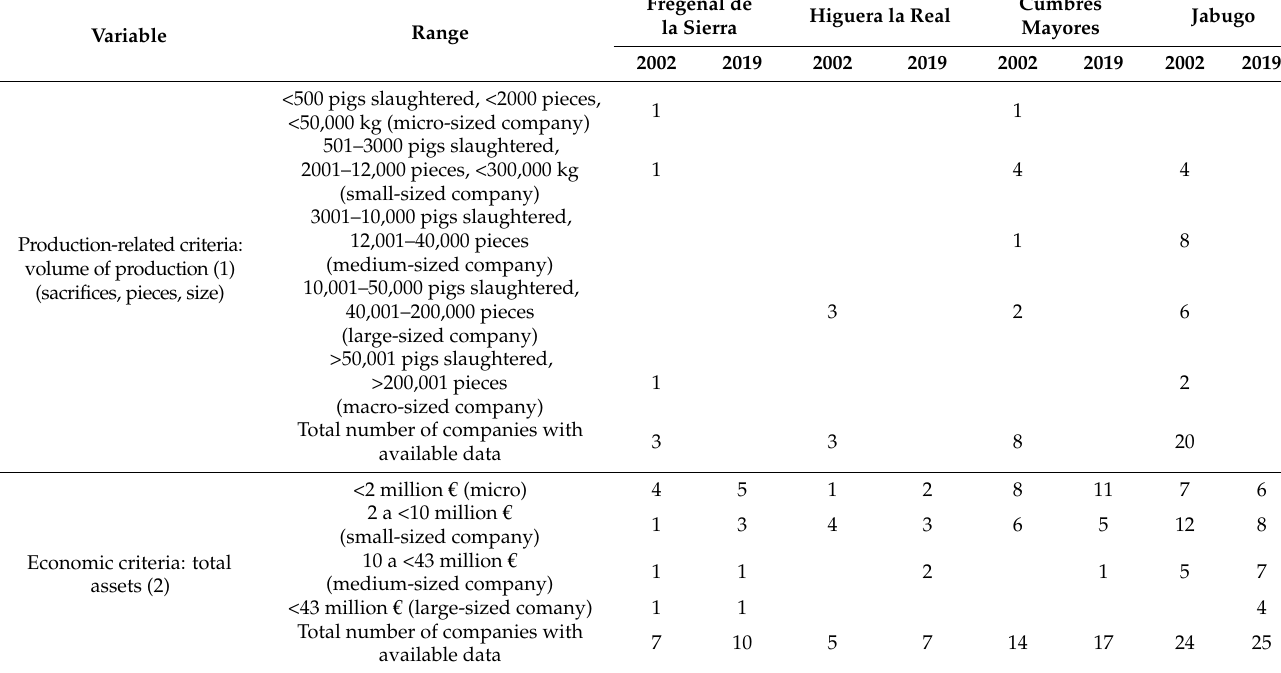
Table 6. Classification of LPS-IPTI companies in terms of production-related and economic criteria (2002–2019) (*).